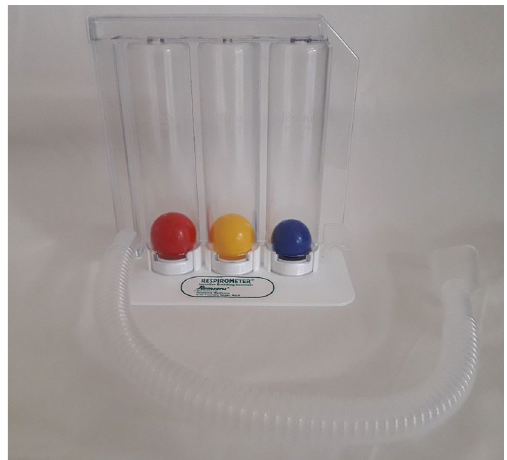
Figure 1. Flow-oriented incentive spirometer (Triflow